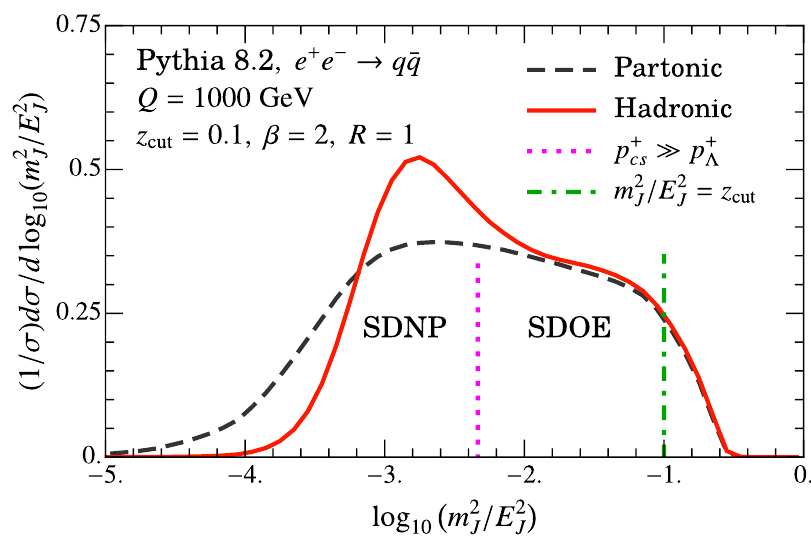
=E 2 distribution indicating three di(cid:11)erent regions of the spec- J J = (cid:25) and the inequality \ (cid:29) " in the \ p + 0 2